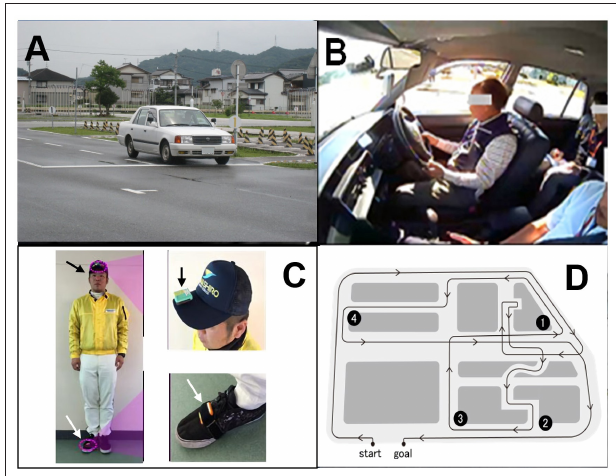
FIGURE 2 | Images of the wearable wireless sensor (WS) and an actual vehicle on the driving experimental course. (A) vehicle overview, (B) in-car view with the driving recorder (DR), (C) WS on the cap (black arrow) and the right shoe (white arrow), (D) driving course map with four locations. ‹ : left turn, › : right turn, fi : right turn without stop sign, fl : left turn with stop sign. The copyright of all photographs belongs to the corresponding author.